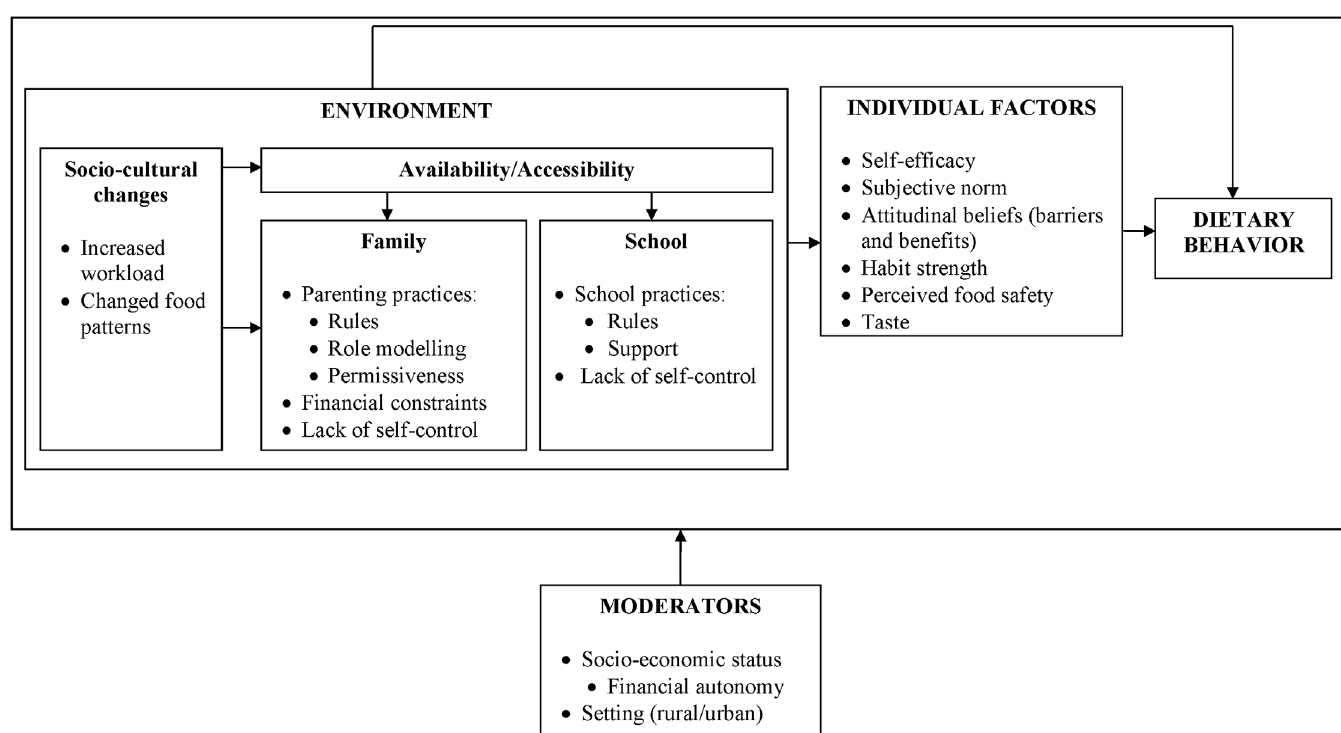
Fig 1. Conceptual framework for healthy dietary behavior in an Ecuadorian